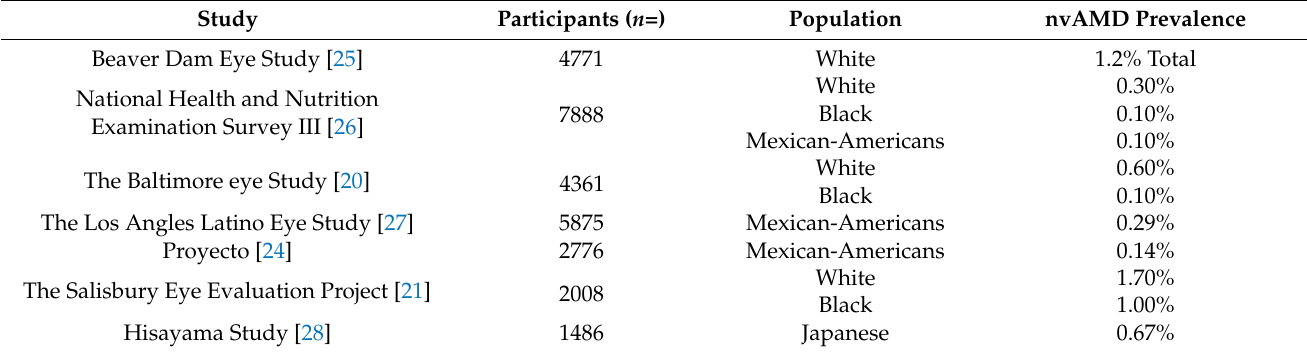
Table 2. nvAMD prevalence between different